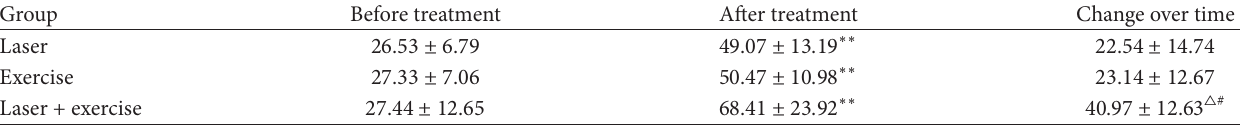
Table 4: Changes in wall squat test time before and after treatment in all therapy groups. Group Before treatment After treatment Change over